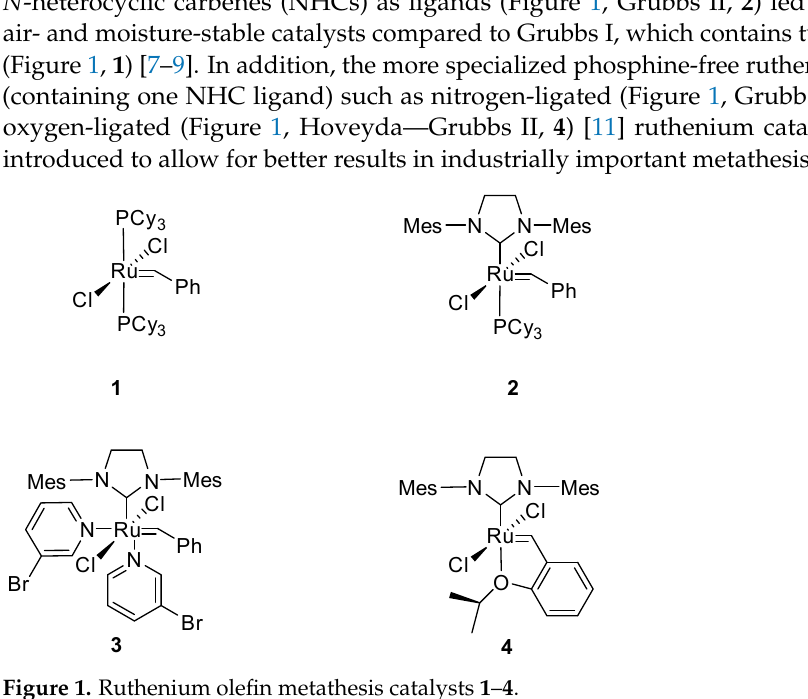
Figure 1. Ruthenium olefin metathesis catalysts 1–4.